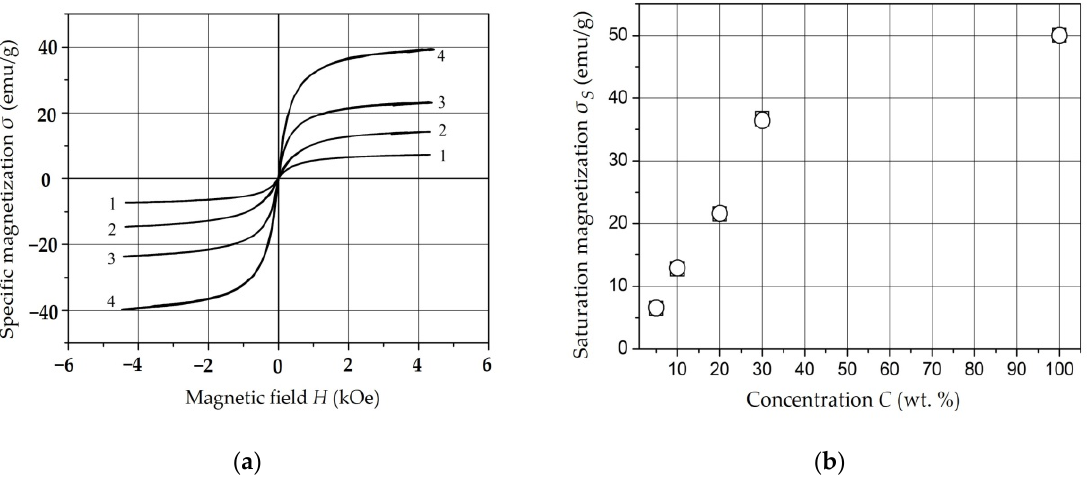
Figure 23. Demagnetization curves of the samples ( σ (emu/g); H (kOe)) ( a ) and dependence of σ S (emu/g) on concentration of NiFe 2 O 4 nanoparticles ( b ) [151].